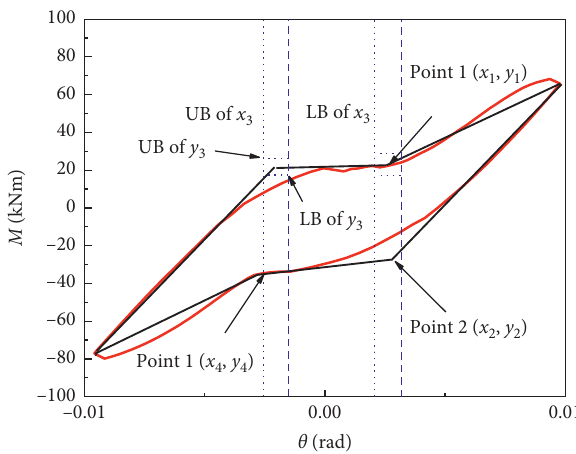
Figure 15: Method to determine the LBs and UBs of the